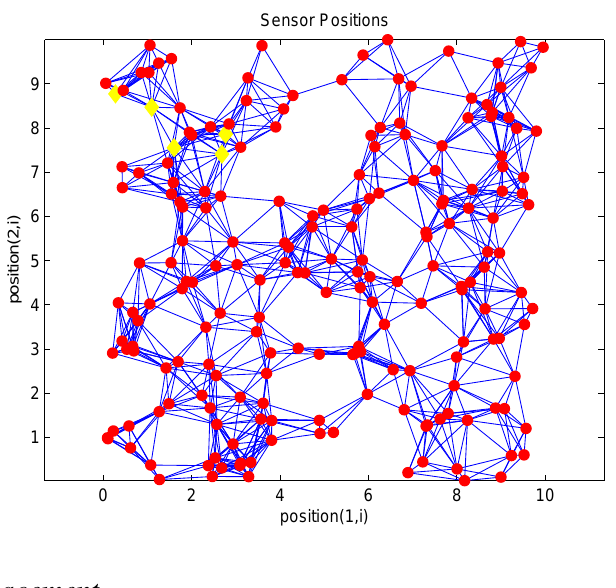
Figure 4 . Uniform